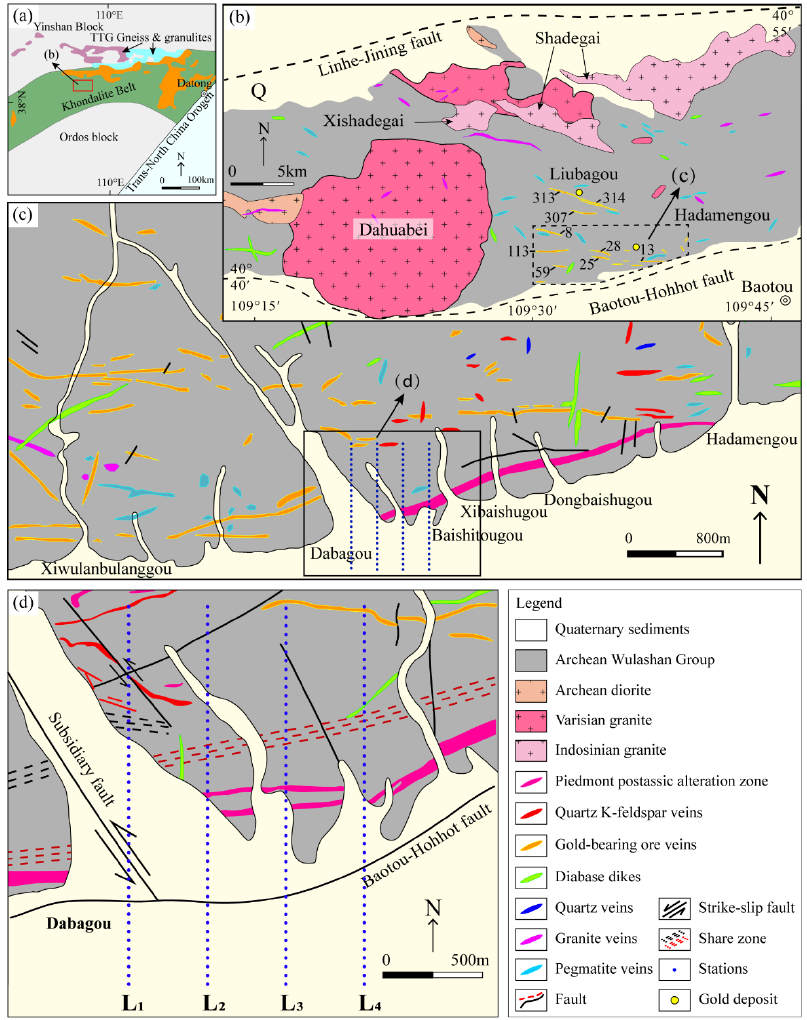
Figure 1. Regional tectonic geological map and CSAMT profile locations. ( a ) Tectonic subdivisions of the NCC (modified from [20]). ( b ) Regional geological structure and intrusive rocks distribution map in the study area (modified from [9]). ( c ) Geological map of the Hadamengou gold deposit and its adjacent areas (simplified from [2]). ( d ) Geological map of the Hadamengou gold deposit (simplified from [2]) and the locations of CSAMT profiles.